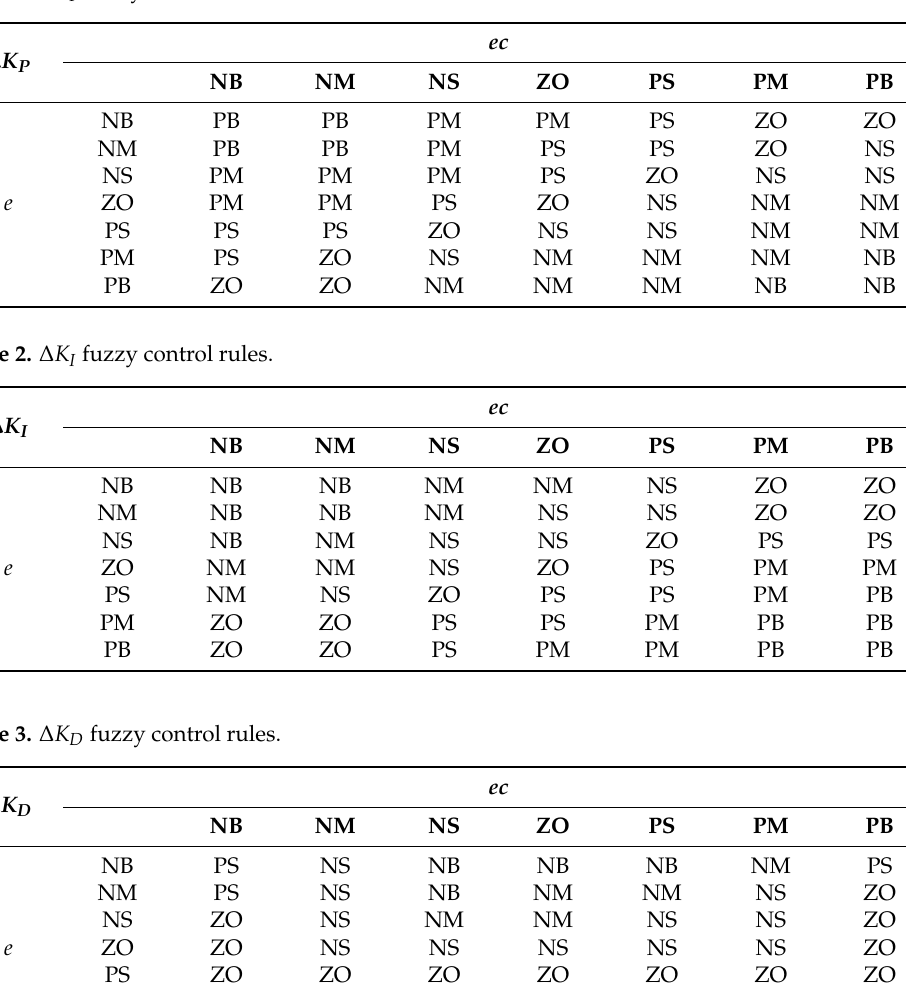
Table 1. ∆ K P fuzzy control rules.